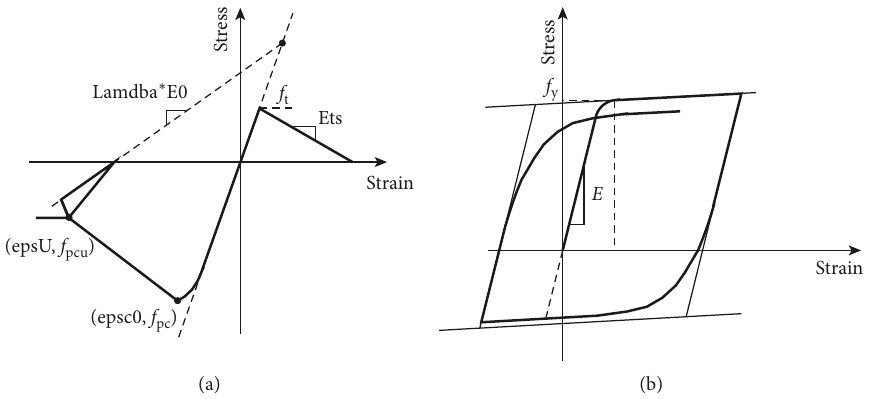
Figure 3: Illustration of material constitutive relation: (a) concrete and (b) steel.